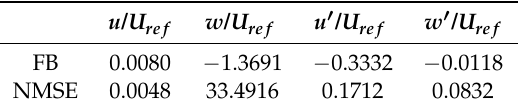
Table A2. FB and NMSE between experiment and simulation for the reference case with canyons of aspect ratio 1 in Section 4.2.